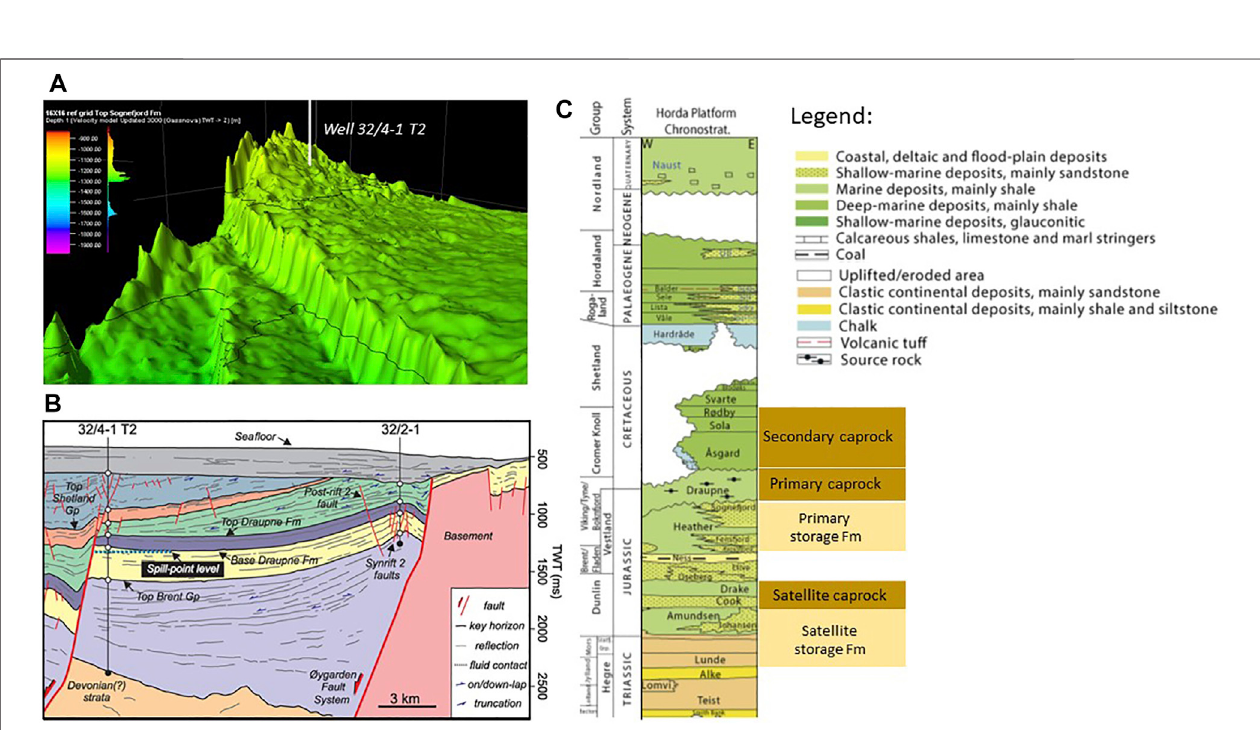
FIGURE 2 | (A) Top Sognefjord Formation showing the location of well 31/4-1 T2 (white line) within the Alpha structure. The vertical exaggeration is 20× (B) Interpreted seismic pro fi le withlocationof well 31/4-1 T2(from Wu et al., 2021). (C) Stratigraphy at the Horda Platform and indication ofprimary and secondary caprock and storage units (from Mulrooney et al., 2020 and references therein).